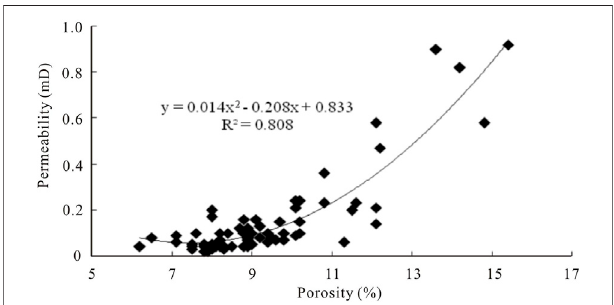
FIGURE 3 | Relationship between porosity and permeability of the samples in the target layer.